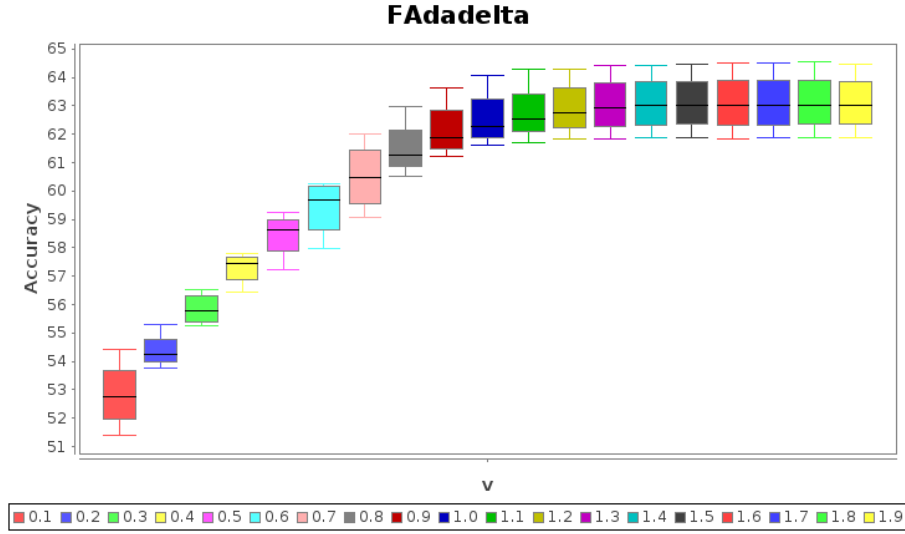
Figure 7. Experiment 2.1: FAdadelta crossfolding accuracies, K = 4 folds, ν ∈ [ 0.1,1.9 ]